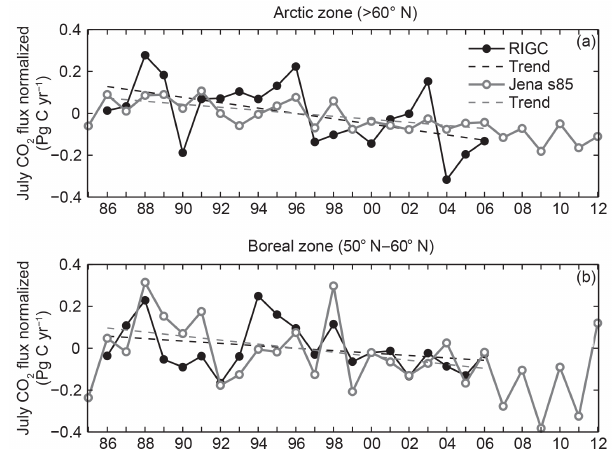
Figure 5. July CO 2 flux anomalies for each inversion for the (a) arctic zone and (b) boreal zone normalized by subtracting the 1986– 2006 mean value. This is the month of maximum CO 2 uptake in each case (see Fig. 3). The dashed lines are the linear trends from 1986 to 2006, also plotted in Fig. 3c and d.